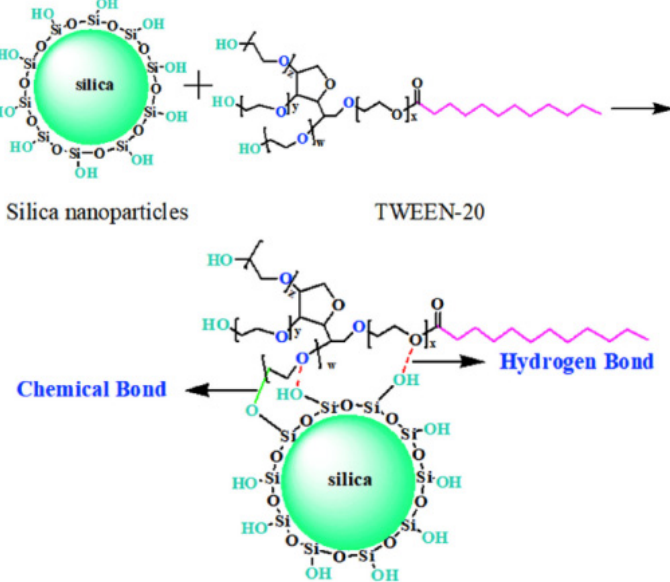
Figure 6. Schematic diagram of the interaction between TWEEN-20 with silica